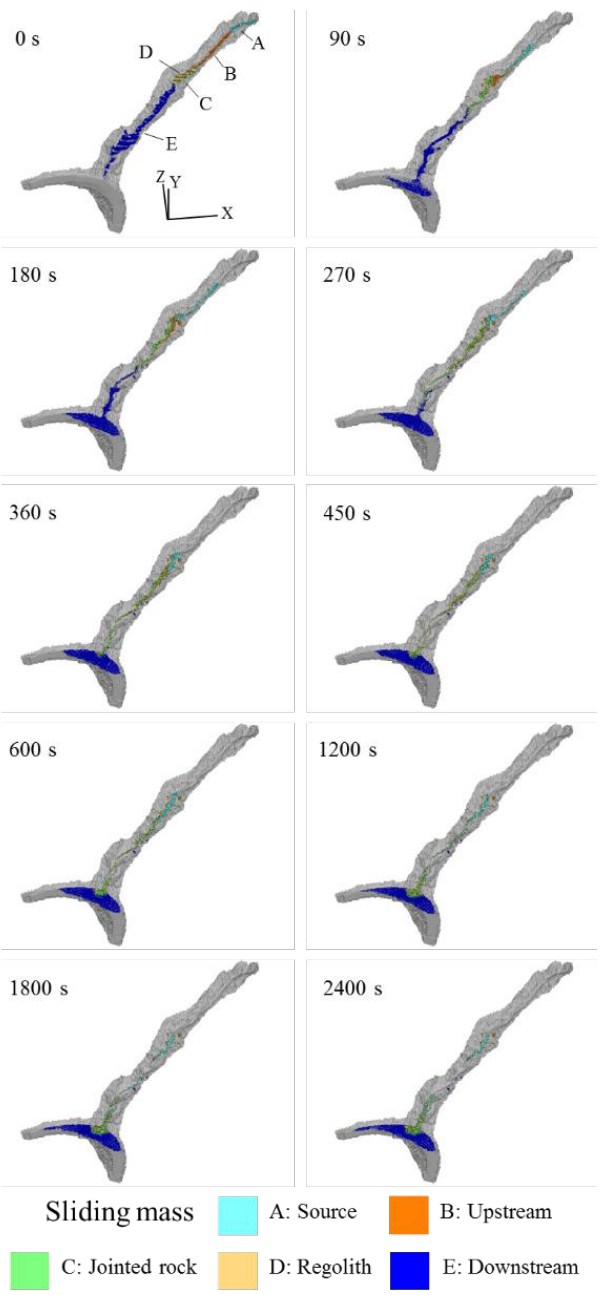
Figure 17. Results of the Zhongzhi landslide simulation.